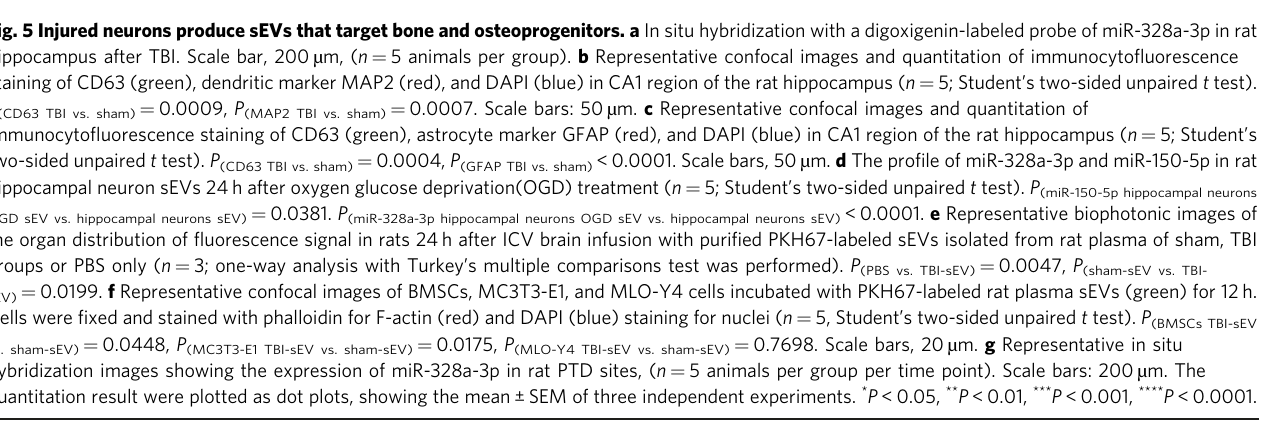
Fig. 5 Injured neurons produce sEVs that target bone and osteoprogenitors. a In situ hybridization with a digoxigenin-labeled probe of miR-328a-3p in rat hippocampus after TBI. Scale bar, 200 µ m, ( n = 5 animals per group). b Representative confocal images and quantitation of immunocyto fl uorescence staining of CD63 (green), dendritic marker MAP2 (red), and DAPI (blue) in CA1 region of the rat hippocampus ( n = 5; Student ’ s two-sided unpaired t test). P = 0.0009, P = 0.0007. Scale bars: 50 µ m. c Representative confocal images and quantitation of immunocyto fl uorescence staining of CD63 (green), astrocyte marker GFAP (red), and DAPI (blue) in CA1 region of the rat hippocampus ( n = 5; Student ’ s two-sided unpaired t test). P (CD63 TBI vs. sham) = 0.0004, P (GFAP TBI vs. sham) < 0.0001. Scale bars, 50 µ m. d The pro fi le of miR-328a-3p and miR-150-5p in rat hippocampal neuron sEVs 24 h after oxygen glucose deprivation(OGD) treatment ( n = 5; Student ’ s two-sided unpaired t test). P (miR-150-5p hippocampal neurons = 0.0381. P (miR-328a-3p hippocampal neurons OGD sEV vs. hippocampal neurons sEV) < 0.0001. e Representative biophotonic images of the organ distribution of fl uorescence signal in rats 24 h after ICV brain infusion with puri fi ed PKH67-labeled sEVs isolated from rat plasma of sham, TBI groups or PBS only ( n = 3; one-way analysis with Turkey ’ s multiple comparisons test was performed). P (PBS vs. TBI-sEV) = 0.0047, P (sham-sEV vs.